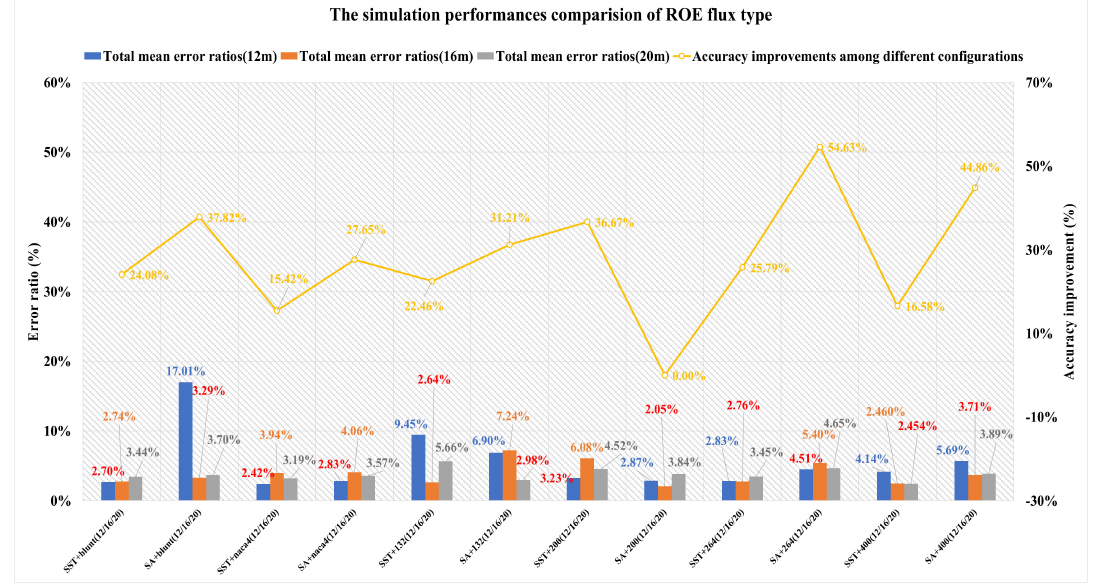
Figure 34. Comparison of the simulation performances of ROE flux type under different simulation configurations. Table 24. The mean error ratios of P/P t , T/T t , and U/U t of the AUSM flux